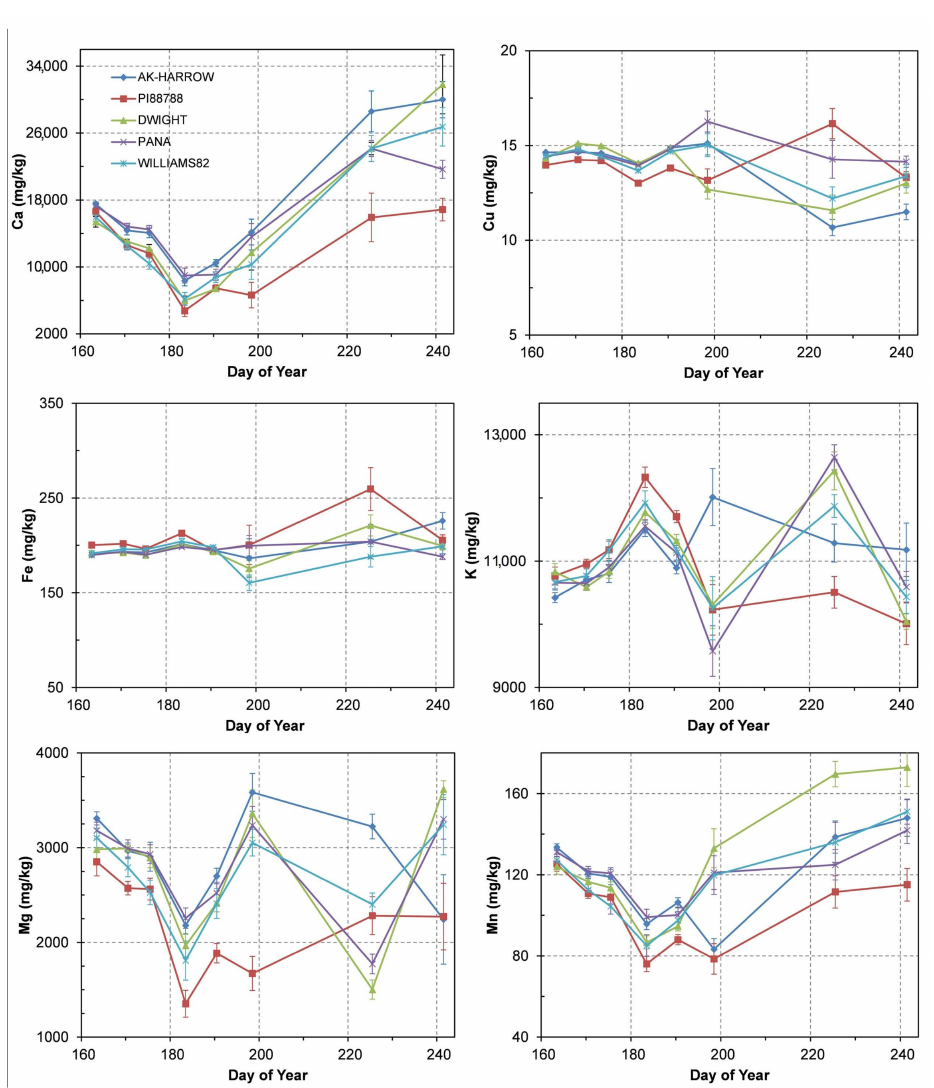
Figure 10. Changes in nutrient concentrations (mean and ± standard error of the mean) by soybean genotypes over